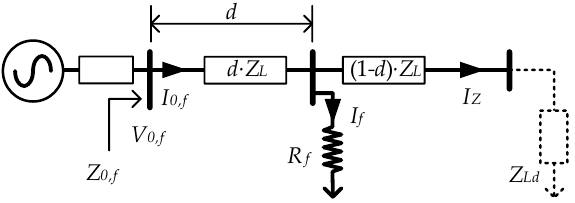
Figure 2. Simplified line model for general one-end